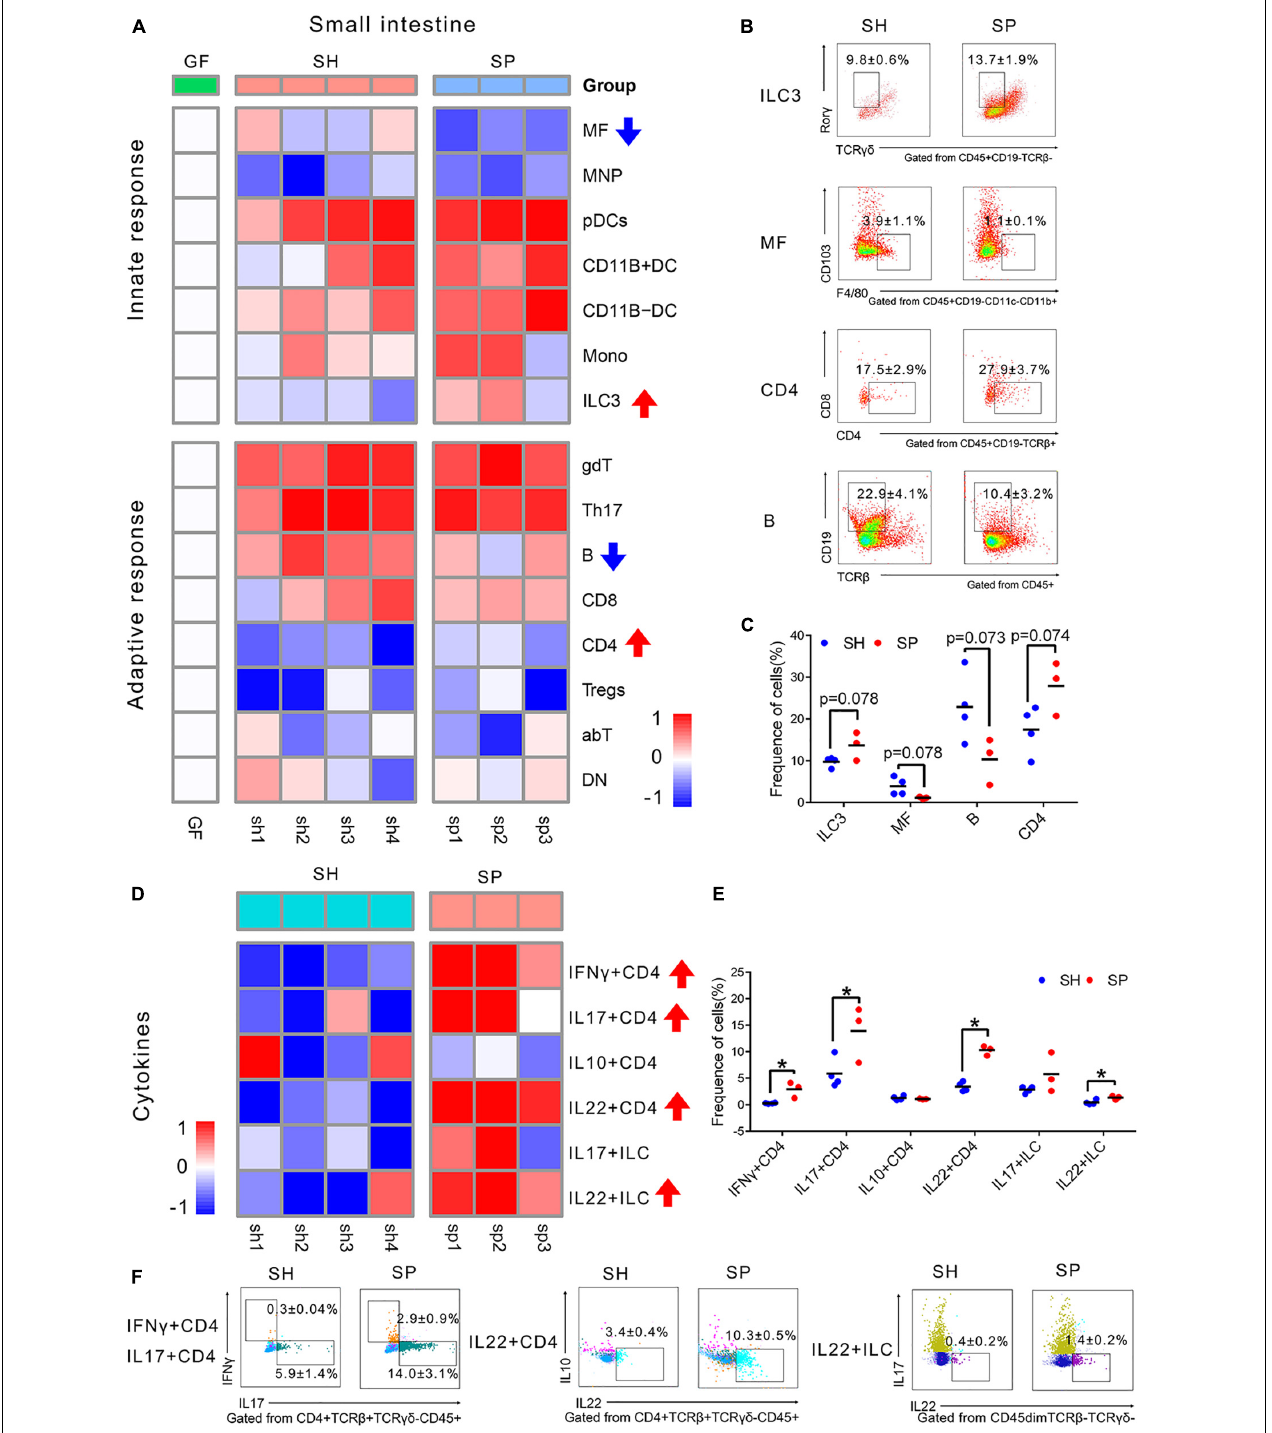
FIGURE 2 | Immune cells changes in the small intestine induced of periodontitis microbiota colonization. (A) Heatmap of 15 immune cells in the small intestine. Compared to SH, the frequency of immune cells was rising, as labeled by red arrows, while those of immune cells was decreased, as labeled by blue arrow in SP. (B) Representative flow cytometry dot plots of ILC3s, MFs, B cells, and CD4 T cells. (C) Histogram of ILC3s, MFs, B cells, and CD4 + T cells. (D) Heatmap of six cytokines in the small intestine. (F) Histogram of cytokines. (E) Representative flow cytometry dot plots of IFN γ + CD4, IL17 + CD4, IL22 + CD4 T cells, and IL22 + ILCs. Data were calculated as means ± SEM. Unpaired Student’s t -tests were performed on all the data. The mean values of the four mice in group GF represented by the one square, while the individual value of each mouse in SH and SP represented by the one square. GF, germ-free mice ( n = 4). Significant results when: * p <